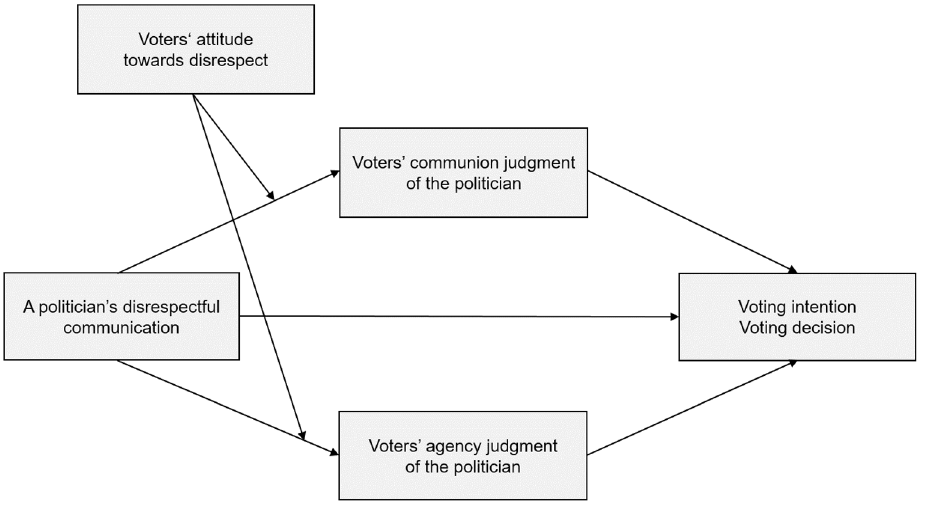
Figure 1. The hypothesized